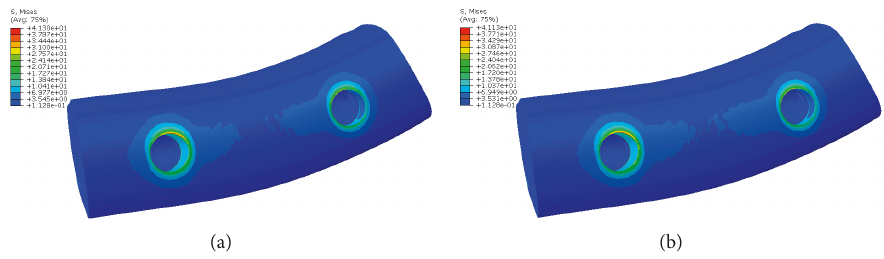
Figure 5: Stress distribution in bone in model 2. (a) PFBM. (b) PFNM.